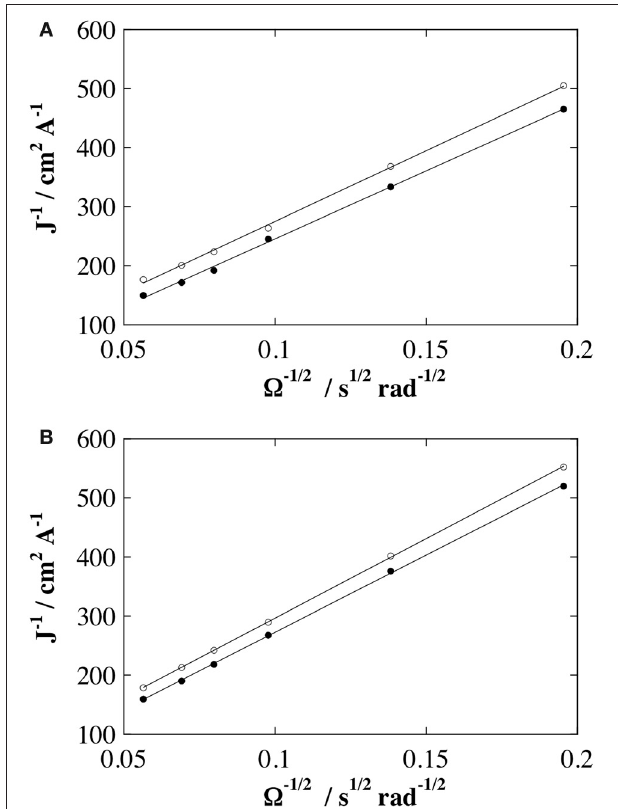
FIGURE 5 | Koutecky-Levich plots obtained with stationary curves at a scan rate of 5 × 10 − 3 V s − 1 in the presence of 2 × 10 − 3 mol L − 1 of hydroquinone in 0.1mol L − 1 PB (pH 7.2), the rotating disk voltammograms were recorded from 0.0 to 1.00V vs. Ag/AgCl at different rotation speeds (from 250 to 3000rpm) on glassy carbon electrode; before (black circle) and after (empty circle) incubation of 8 . 3 × 10 − 6 mol L − 1 of specific lectin (PNA or MAA). (A) Poly(pyrrole-lactosyl) film ( (cid:3) = 2 . 1 × 10 − 9 mol cm − 2 ) (black circle) and poly(pyrrole-lactosyl) film + PNA (empty circle). (B) Poly(pyrrole-3 (cid:2) -sialyllactosyl) film ( (cid:3) = 2 . 8 × 10 − 9 mol cm − 2 ) (black circle) and poly(pyrrole-3 (cid:2) -sialyllactosyl) film + MAA (thin